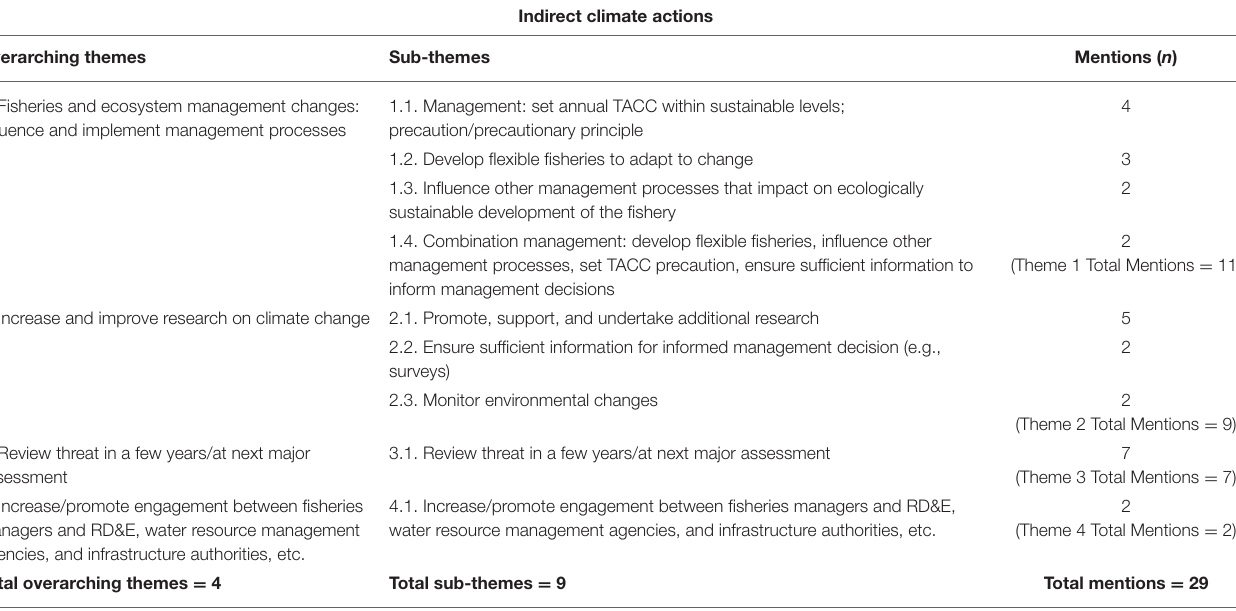
Indirect climate actions